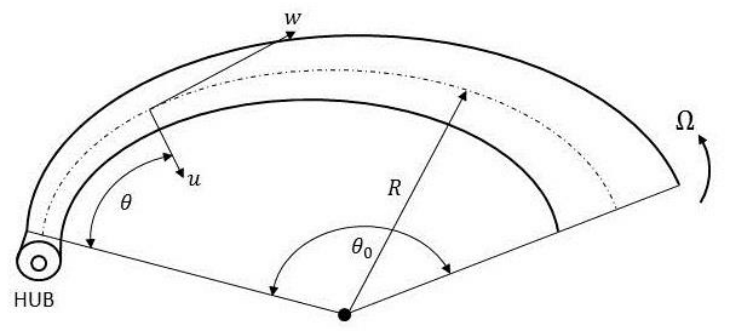
Figure 1. Geometry of a scimitar-type curved beam.